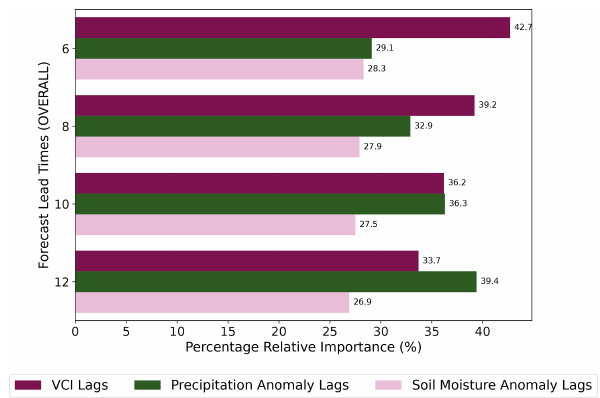
Figure 11. Bar plots showing the cumulative (all lags) relative im- portance of additional variables to the VCI3M forecast for all coun-